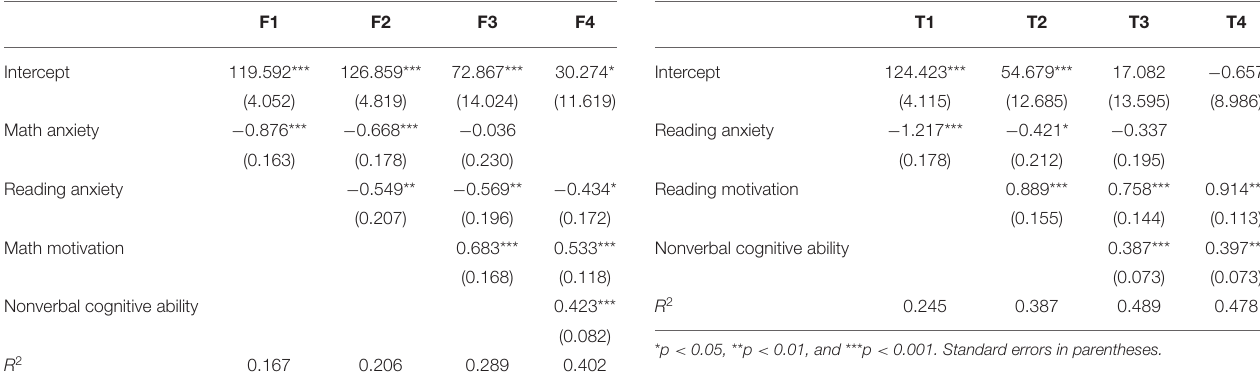
TABLE 6 | Taxonomy of models examining the relation between Total Word Reading Efficiency, reading anxiety, reading motivation, and nonverbal cognitive ability ( n =